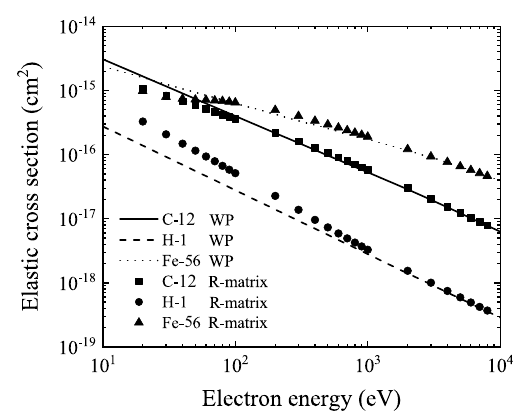
Figure 1. Cross section of C, H, Fe with electron energy above 10eV. WP stands for wave partial method